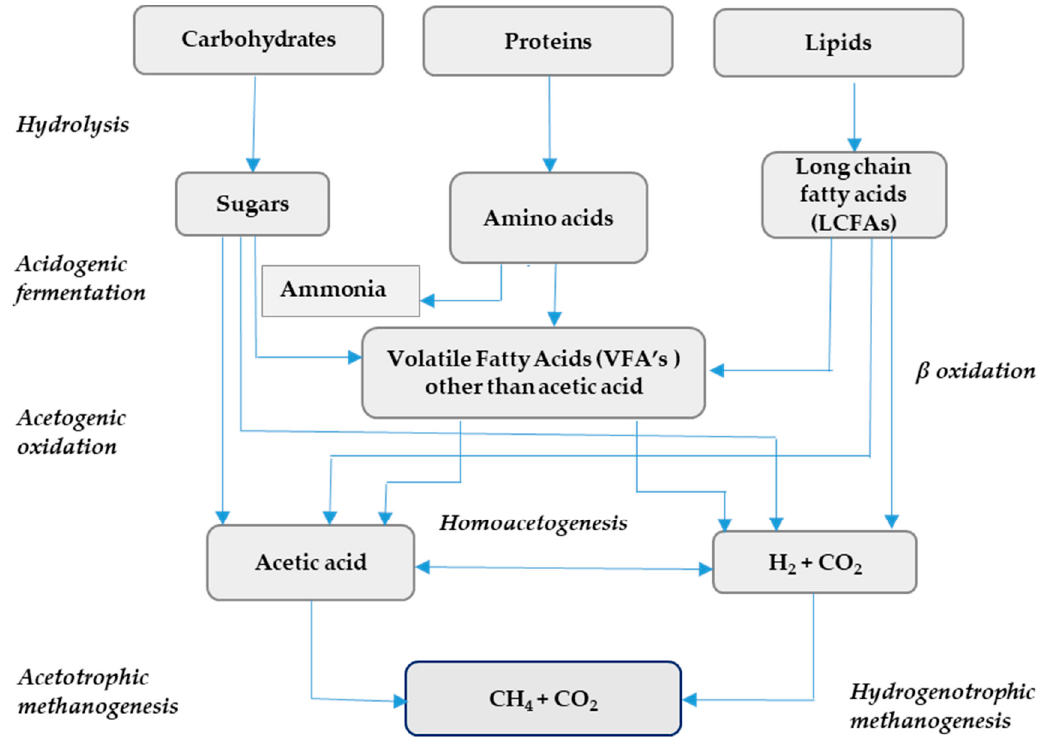
Figure 1. Pathways of anaerobic digestion for biomethane production.